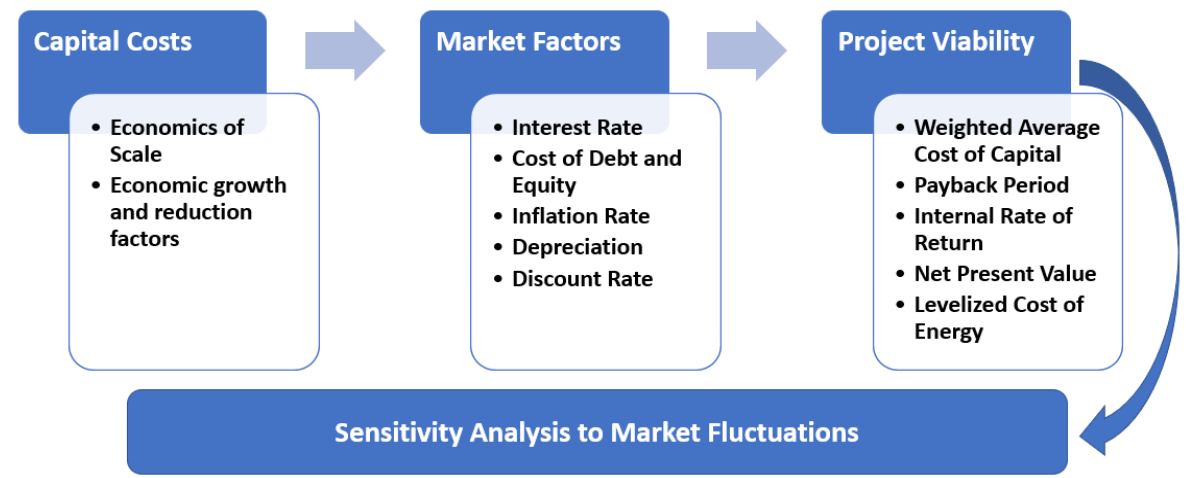
Figure 4. Overview of techno-economic analysis .